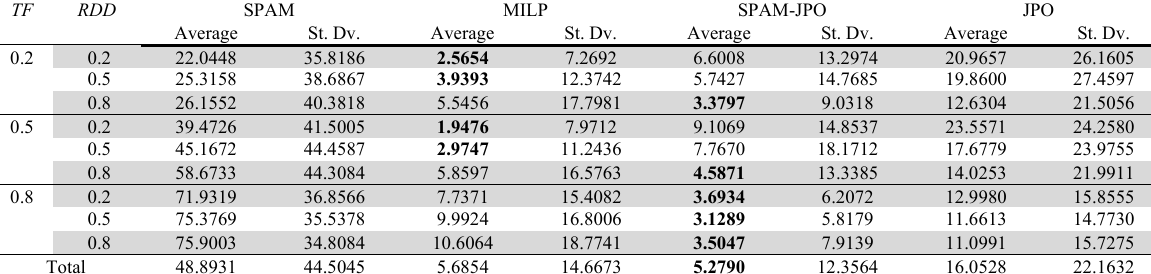
Large-sized test instances: RDI values for TF and RDD (part 2)